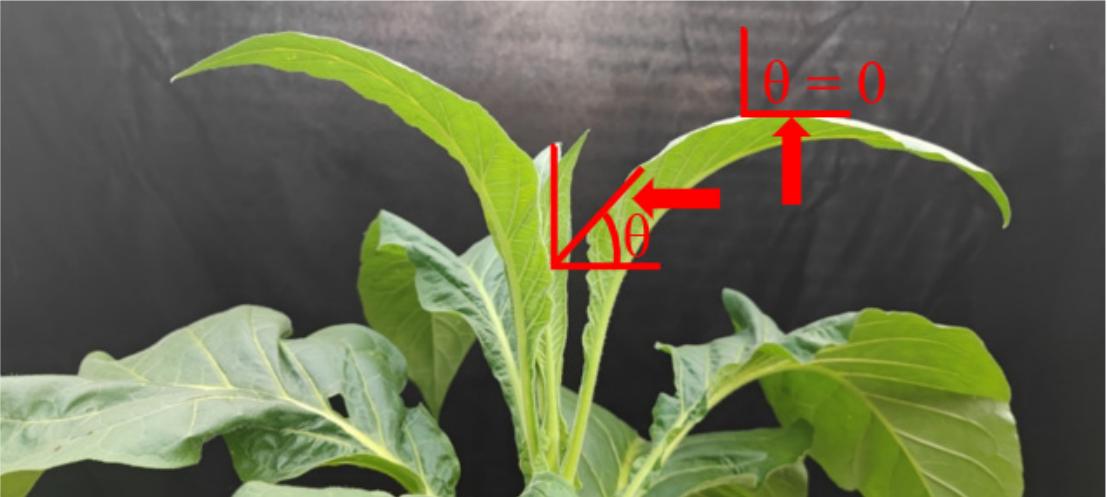
Figure 1. Photographs of tobacco leaves. The symbol θ indicates the leaf angle.